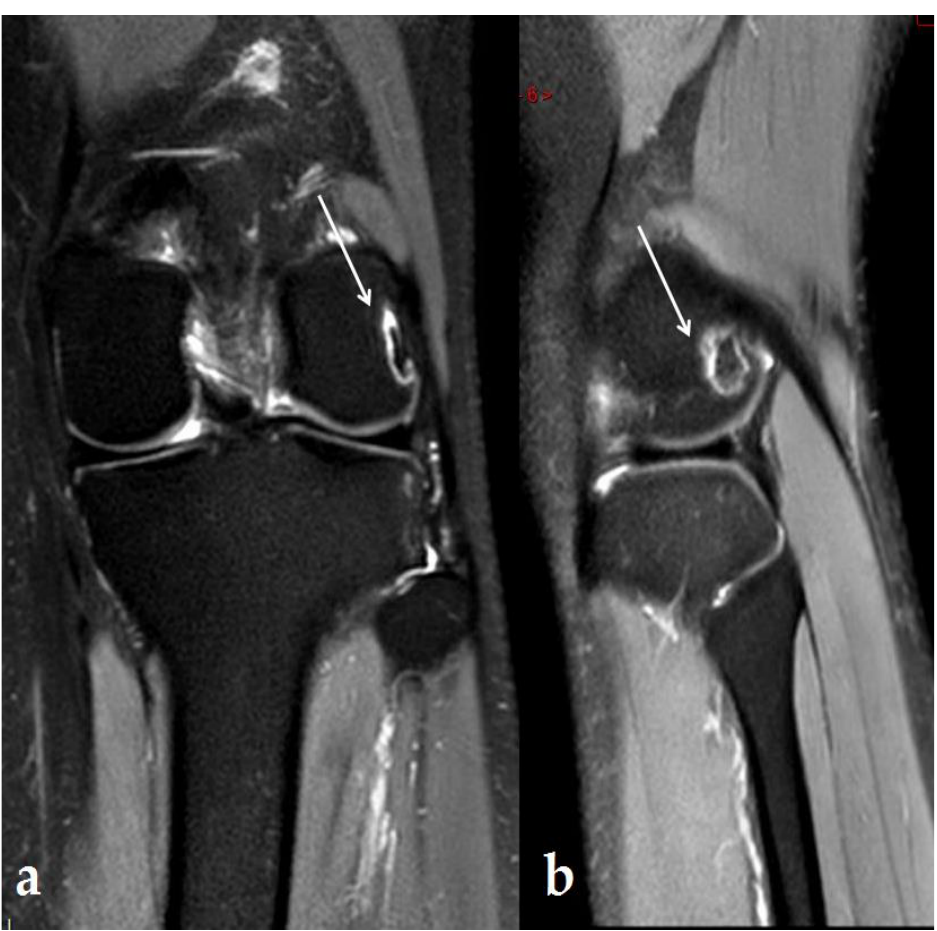
Figure 5. MRI: 11 months after the last US therapy. DP FS MRI image in frontal ( a ) and sagittal ( b ) sections showing remaining bone abnormality. At the last follow-up, only a single lesion persisted on the femur of 8 × 9 × 5 mm. arrows show lesion.